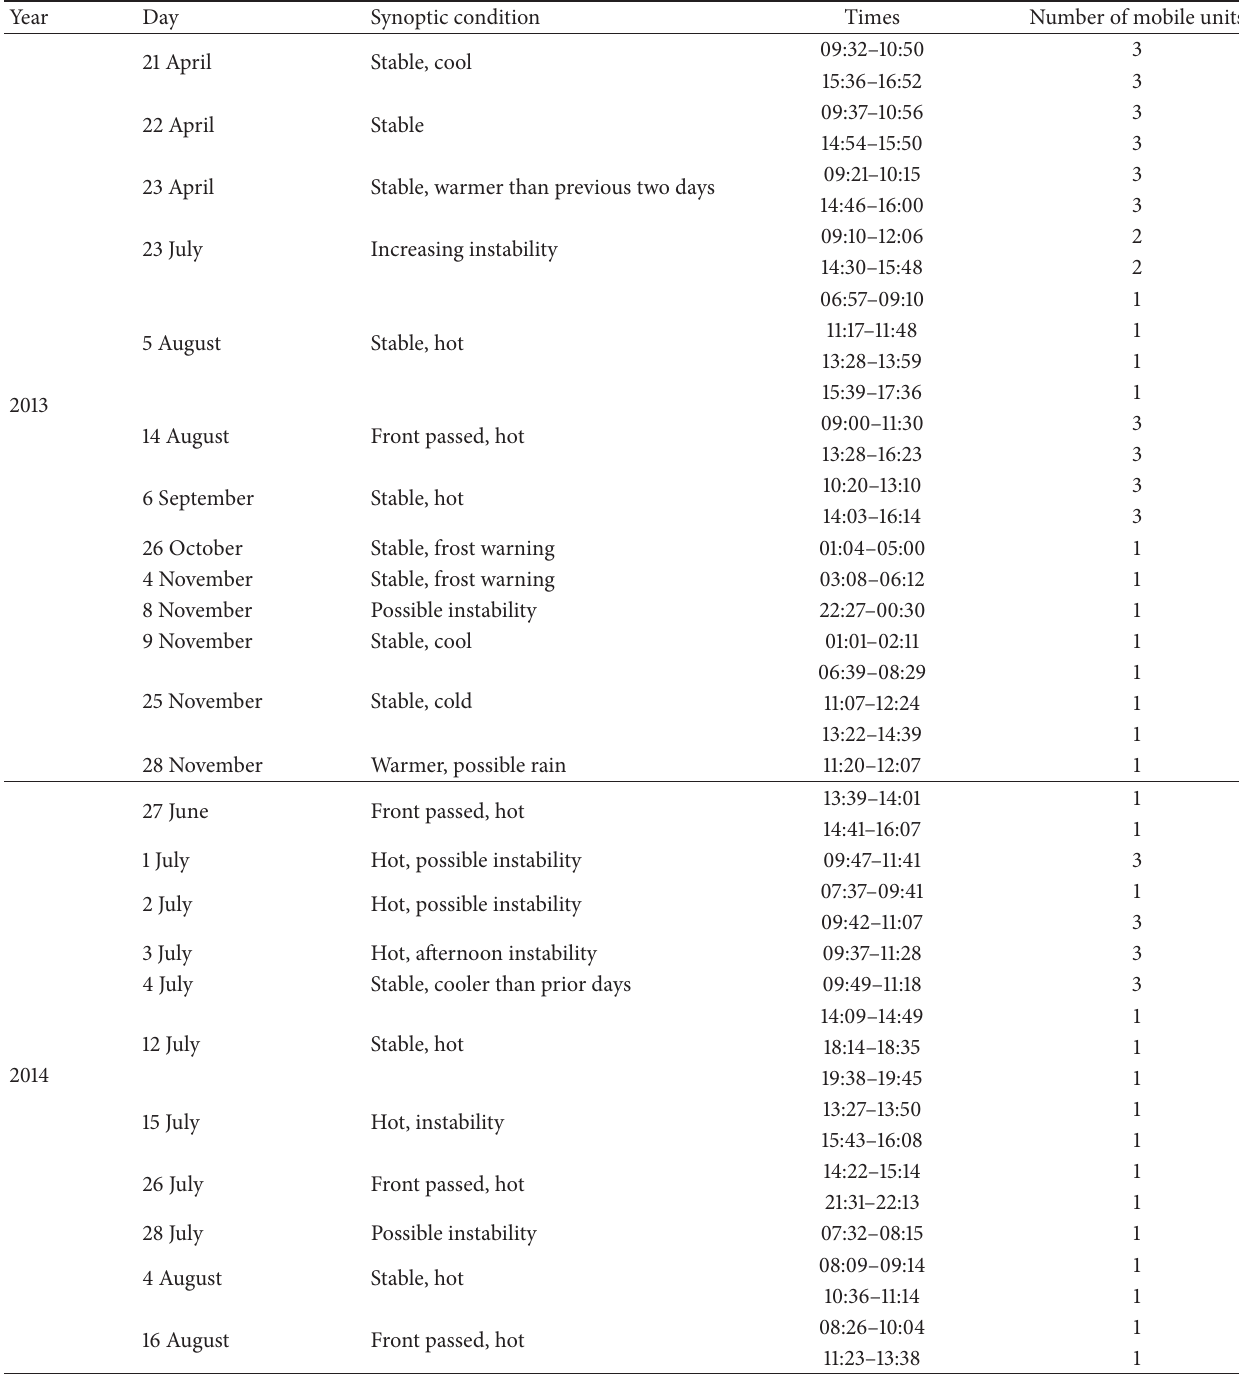
Table 3: Mobile transect collection